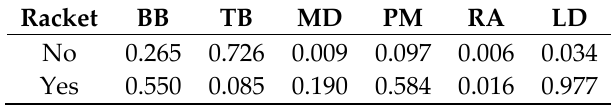
Table 6. P -value of mean amplitude for One Stroke (forward stroke).